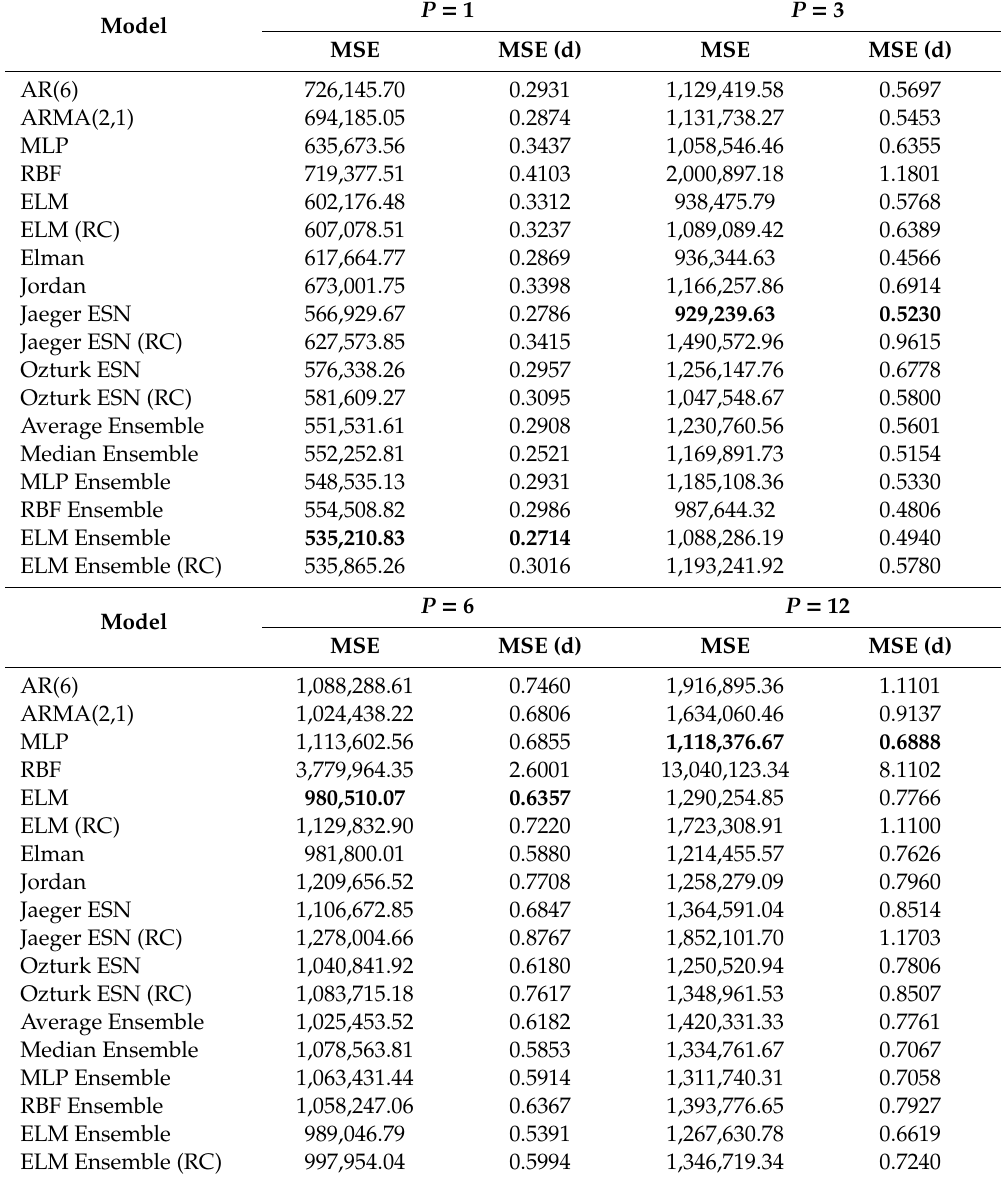
Table 5. Computational results for Paulo